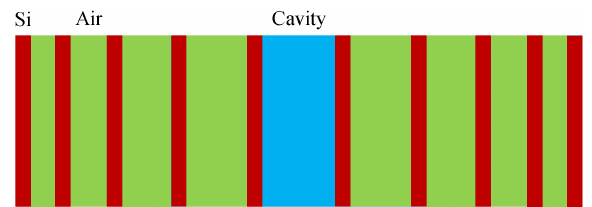
Figure 10. 1-D photonic crystal nanocavity with the thickness of the air layers changing linearly. The thickness of the air layer is increased linearly from 0.22 to 0.55µm on the left side of the cavity and is decreased linearly from 0.55 to 0.22µm on the right side of the cavity. The cavity length is d cavity = 0 . 66µm for a cavity mode with a central wavelength of